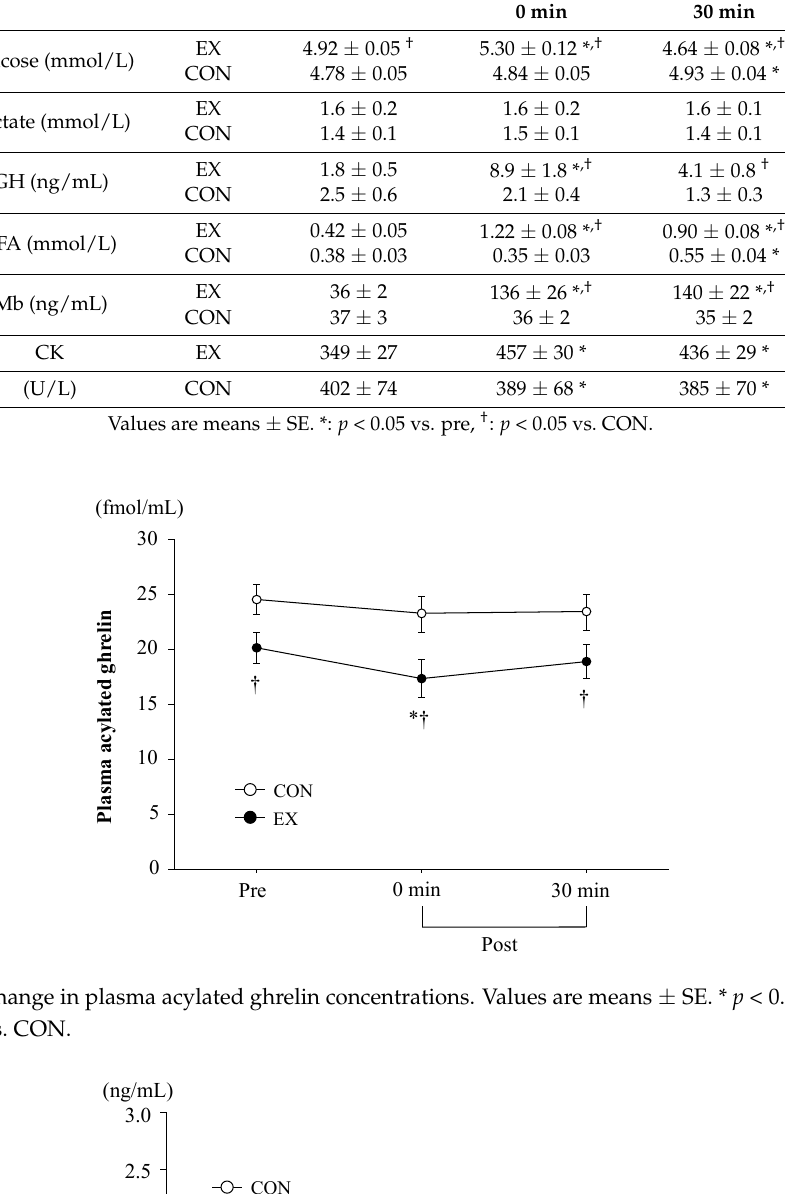
Table 2. Change in blood variables.